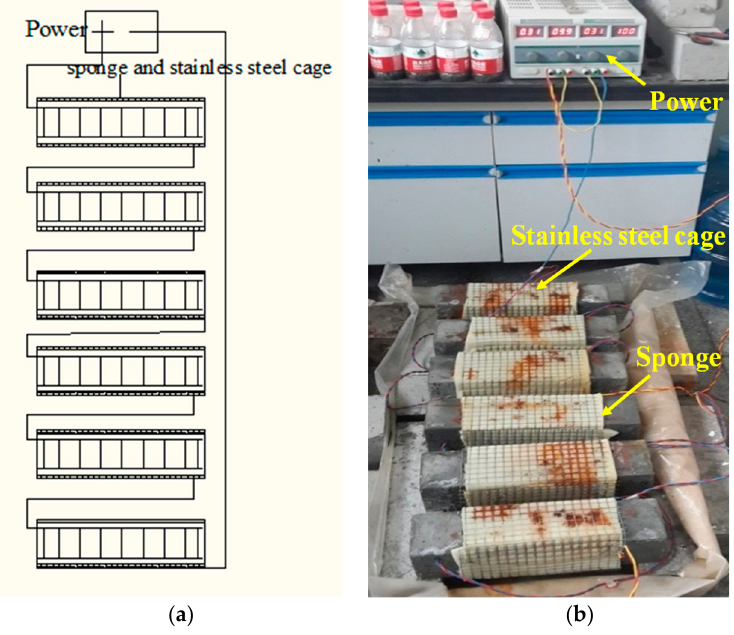
Figure 2. Accelerated corrosion test.